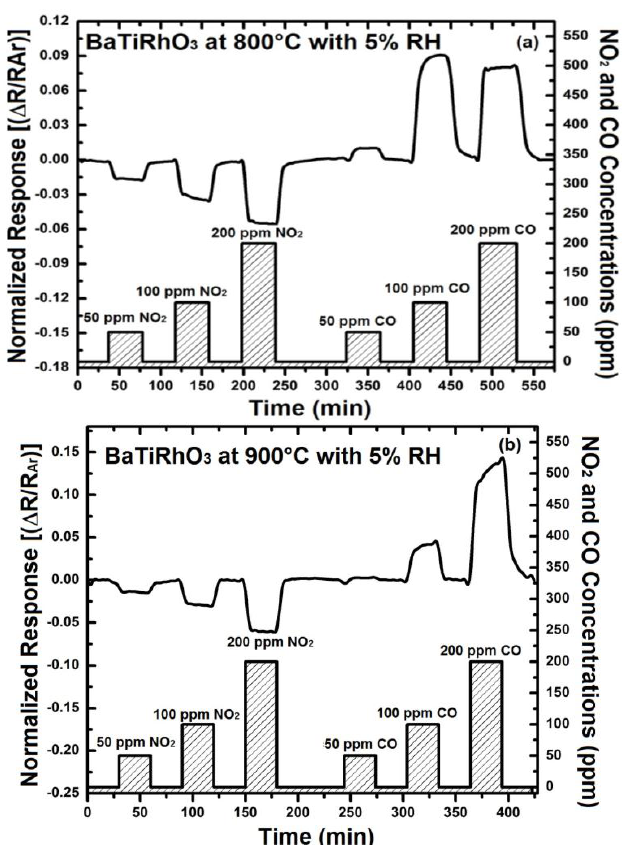
Figure 9. ( a ) Sensor response of only BaTi 0.95 Rh 0.05 O 3 thick catalytic layer towards NO 2 at 800 °C, and ( b ) at 900 °C in the presence of 5% humidity.